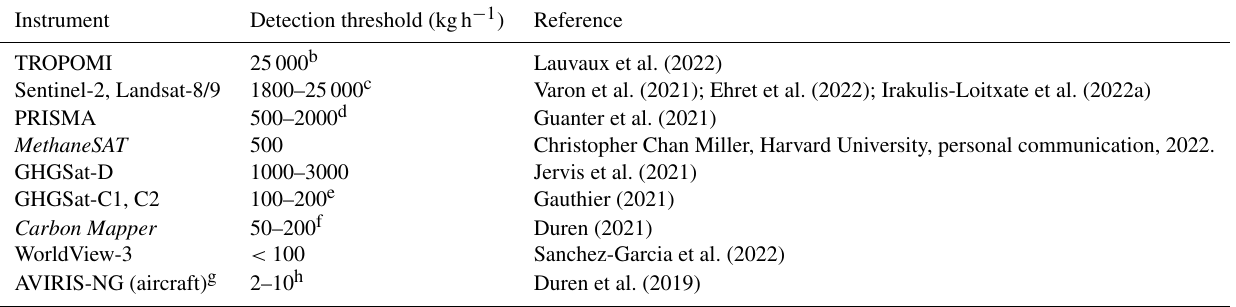
Table 4. Point source detection thresholds for different satellite instruments a